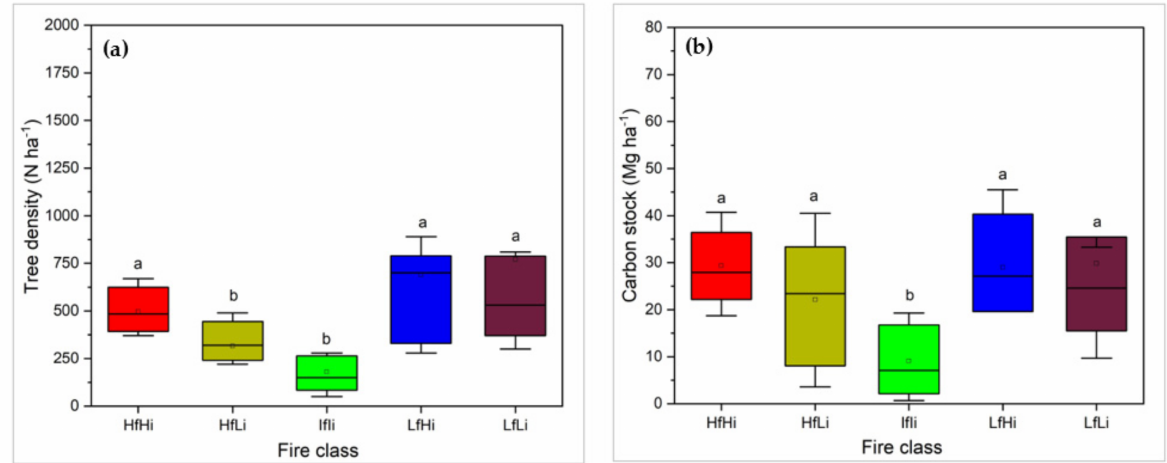
Figure 3. Wood vegetation parameters under different fire strata ( a ) tree density and ( b ) above tree carbon stock. Means ( ± standard deviation) that do not share a letter are significantly different (Kruskal–Wallis test; α =